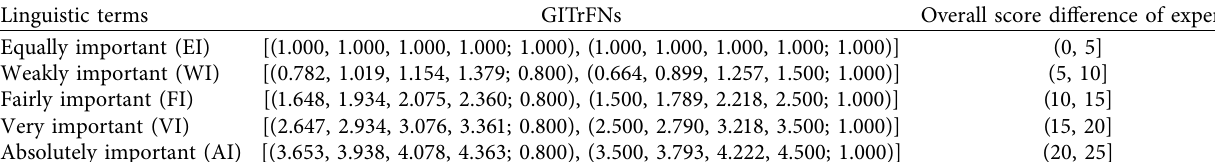
Table 1: The corresponding GITrFNs and the expert score difference of the linguistic terms for the GITrF-BWM. Linguistic